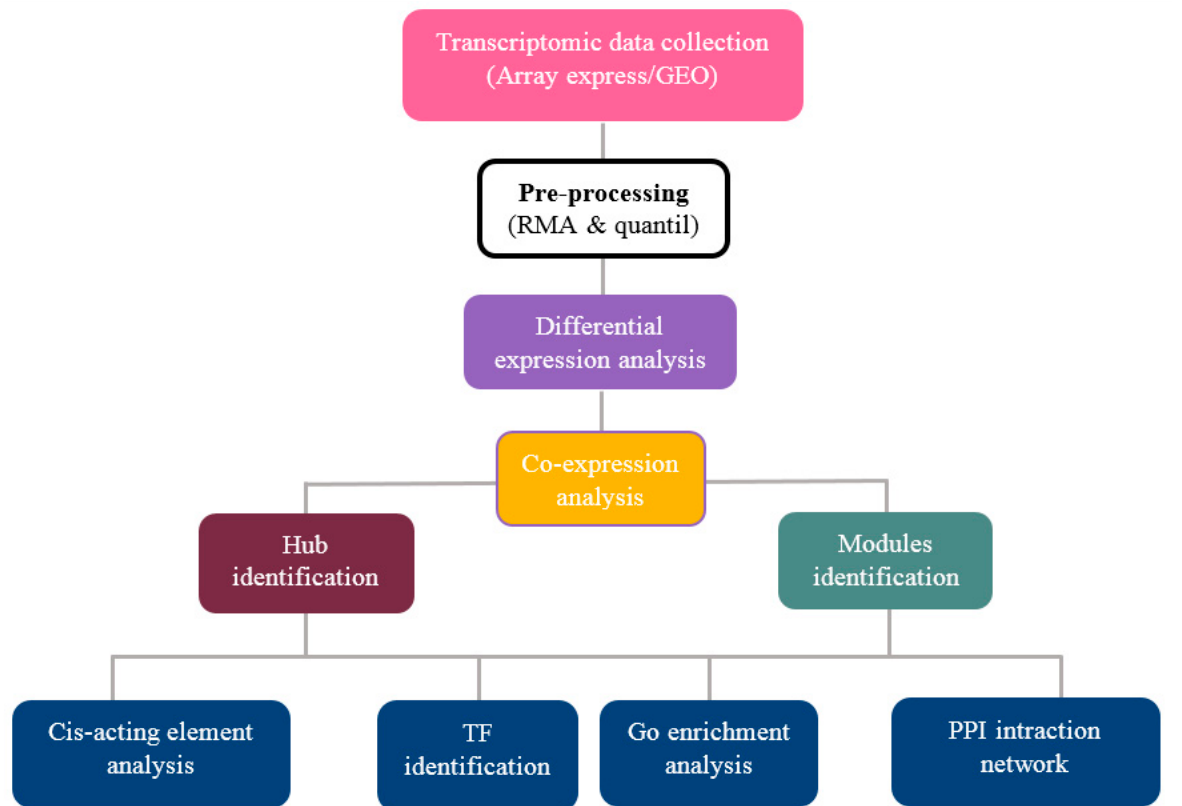
Figure 1. Workflow for data collection, pre-processing, and co-expression network analysis to assess aspects of the responses of soybeans to the effects of drought stress.